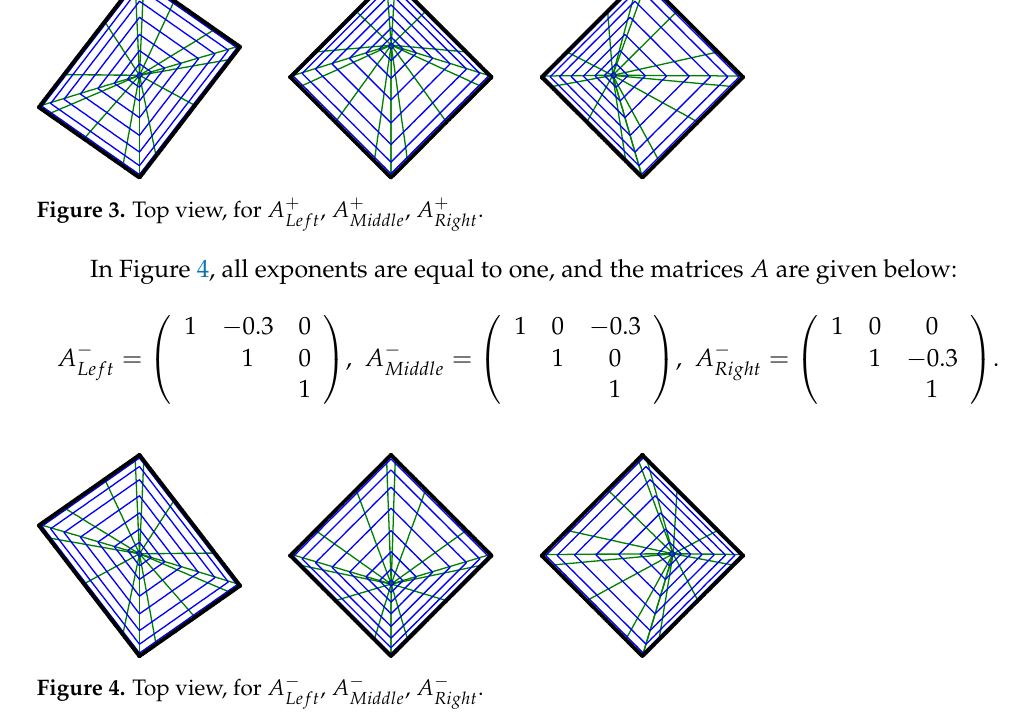
Figure 4. Top view, for A −